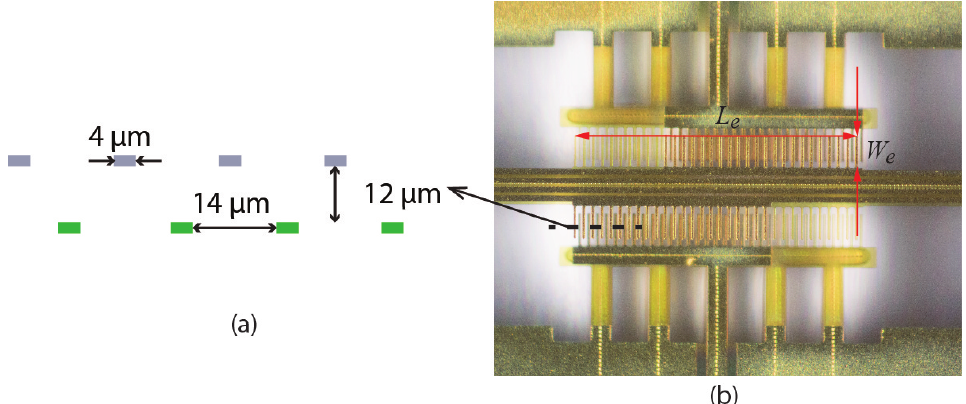
Figure 2. Schematic cross section ( a ) and close up photograph ( b ) of a capacitive readout structure. Two capacitors, one at each side of the channel, are formed by interdigitated combs. The combs shown in gray in the cross section are attached to the vibrating channel while the combs shown in green are attached to the silicon substrate. L e = 580µm, W e =